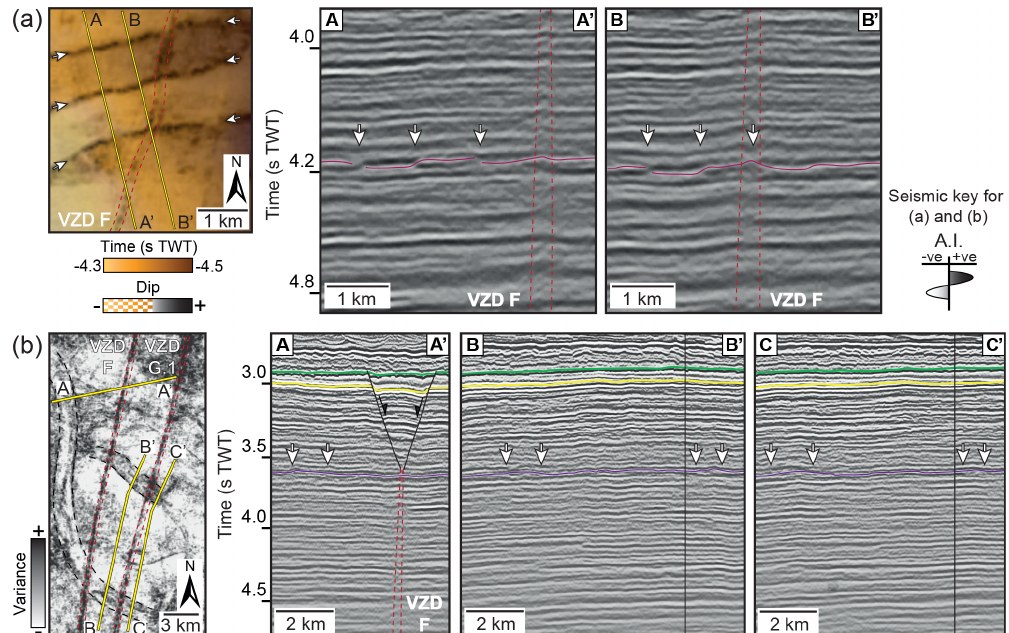
Figure 8. (a) Two-way time structure map and seismic sections showing linear structures (e.g. possible fluvial channel boundaries) within the Mungaroo Formation that are cross-cut but not laterally or vertically offset by VZD F. The structure map is of the stratigraphic horizon interpreted in the seismic sections. (b) Variance map and seismic sections showing fluvial channels within the Mungaroo Formation are cross-cut but not laterally or vertically offset by the VZD F. The variance map is of the stratigraphic horizon interpreted in the seismic sections. See Fig. 4c for locations of (a) and (b)